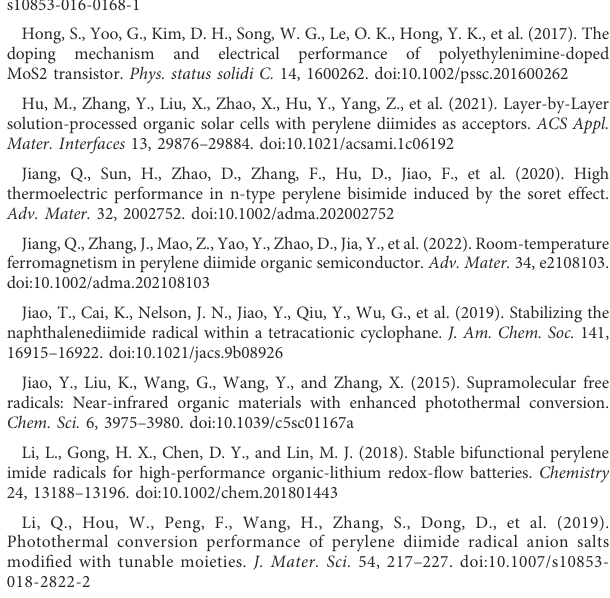
SUPPLEMENTARY FIGURE S1 In situ UV-vis spectra of PDI at time = 0 s (black curve) and 500 s (red curve) under constant voltage. Pristine PDI (~10 – 4 M) in DMF with 0.1 M Bu 4 NPF 6 was used as the electrolyte, a constant voltage of − 1.8 V (which is enough to reduce PDI to get radical anion and dianion in a relatively short time) was applied at the Pt working electrode, the counter electrode is Pt and the reference electrode is Ag/Ag + . SUPPLEMENTARY FIGURE S2 Dynamic Light Scattering result of the PDI-PEI suspension. SUPPLEMENTARY FIGURE S3 g-factor ofPDI suspension dopedwith PEI contentunderamolarratio ofPEI repeat unit to PDI equals to 9.1, 453.6, and 907.2. SUPPLEMENTARY FIGURE S4 (A) M-H hysteresis loops measured four times (1st: one day; 2nd: 13 days; 3rd: 22 days; 4th: one month) for the sample molar ratio of PEI repeat unit/ PDI=453.6; (B) ferromagneticcontribution extractedfromSupplementary Figure S4A. SUPPLEMENTARY FIGURE S5 LUMO-HOMO energy of PDI with or without PEI: (A) Linear sweep voltammograms obtained in the glovebox of PDI aggregation in DMF withoutPEI(black),withvariousamountsofPEI(red)andthePDImonomer produced by oxidizing the doped PDI solution with air (blue); (B) UV-vis spectra of PDI aggregation in DMF with or without PEI used for the calculation of the energy gap between their HOMO and LUMO. The PDI suspensions in DMF with or without PEI are sonicated before cyclic voltammetry, PDI concentration: 0.05 mg/mL, the numbers in the brackets represent the PEI/PDI mass ratio 0, 1, 10, 50, 100, and 1000. Scan rate: 100 mV/s, working electrode: glassy carbon (Diameter = 3 mm); The LUMO energyfor oxygen andwater reductionwasestimated fromonset reduction potential from (C) linear sweep voltammograms of DMF electrolyte with